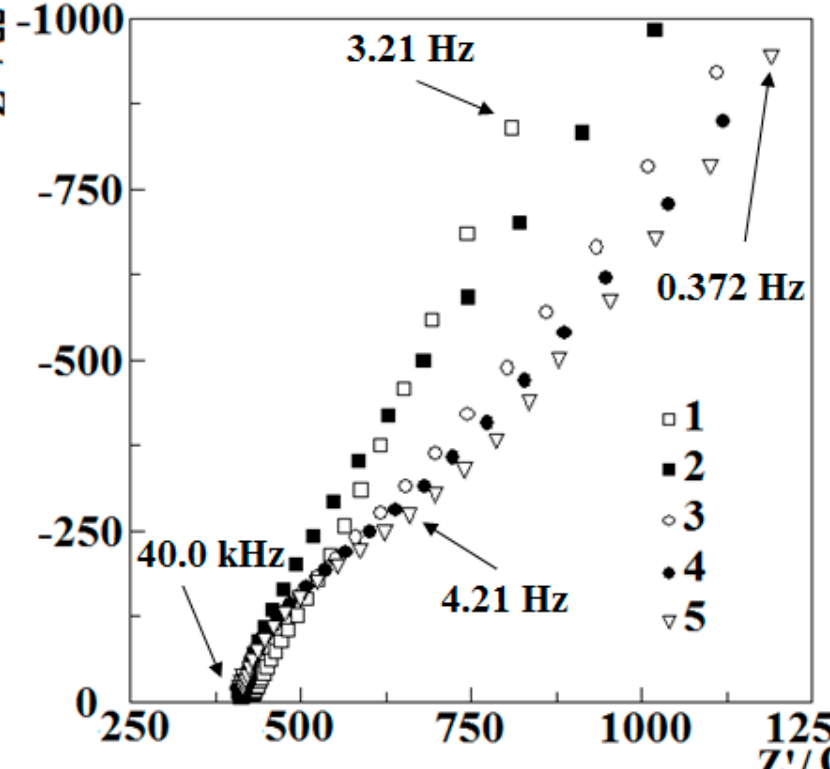
Figure 2. EIS data registered during the polymerization, 1–recorded before polymerization, 2–after 3, 3–after 6, 4–after 9 and 5–after 18 polymerization cycles. EIS data were recorded in a frequency range of 40.0 kHz–372 mHz at 0 V vs Ag/AgCl/KCl (3M KCl) , in acetonitrile-based solution consisting of 0.001 M PQ and 0.1 M of tetra- n -butylammonium perchlorate.